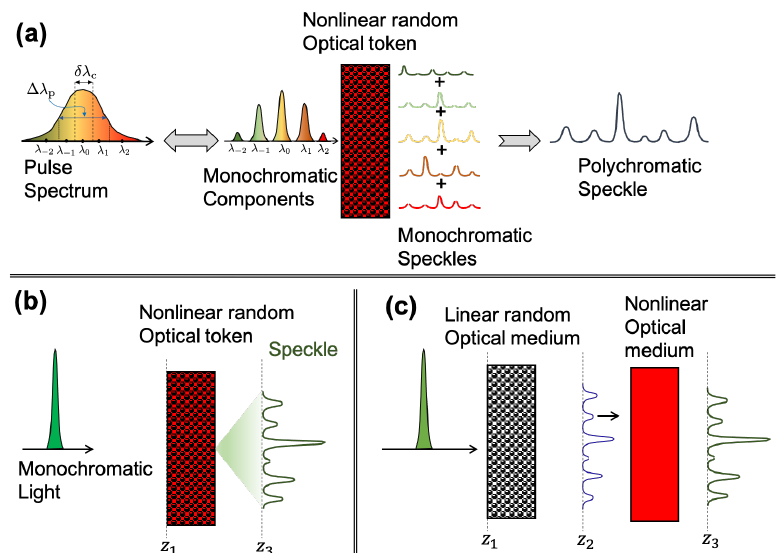
Figure 1. Schematic representation of the theoretical model under consideration for the scattering of a Fourier-limited laser pulse from a multiple scattering nonlinear token. ( a ) For a token with spectral correlation bandwidth δλ c and a pulse of bandwidth ∆ λ p , there are N (cid:39) ∆ λ p / δλ c spectral degrees of freedom, corresponding to wavelengths λ 0 , λ ± 1 , . . .. Different spectral components pertain to independent random monochromatic transmission matrices, and they give rise to uncorrelated monochromatic speckles. ( b , c ) The scattering of the i th spectral component from the nonlinear random token is treated as a sequential process, pertaining to the scattering from a linear multiple- scattering token and the propagation of the resulting fully developed monochromatic speckle in a nonlinear homogeneous